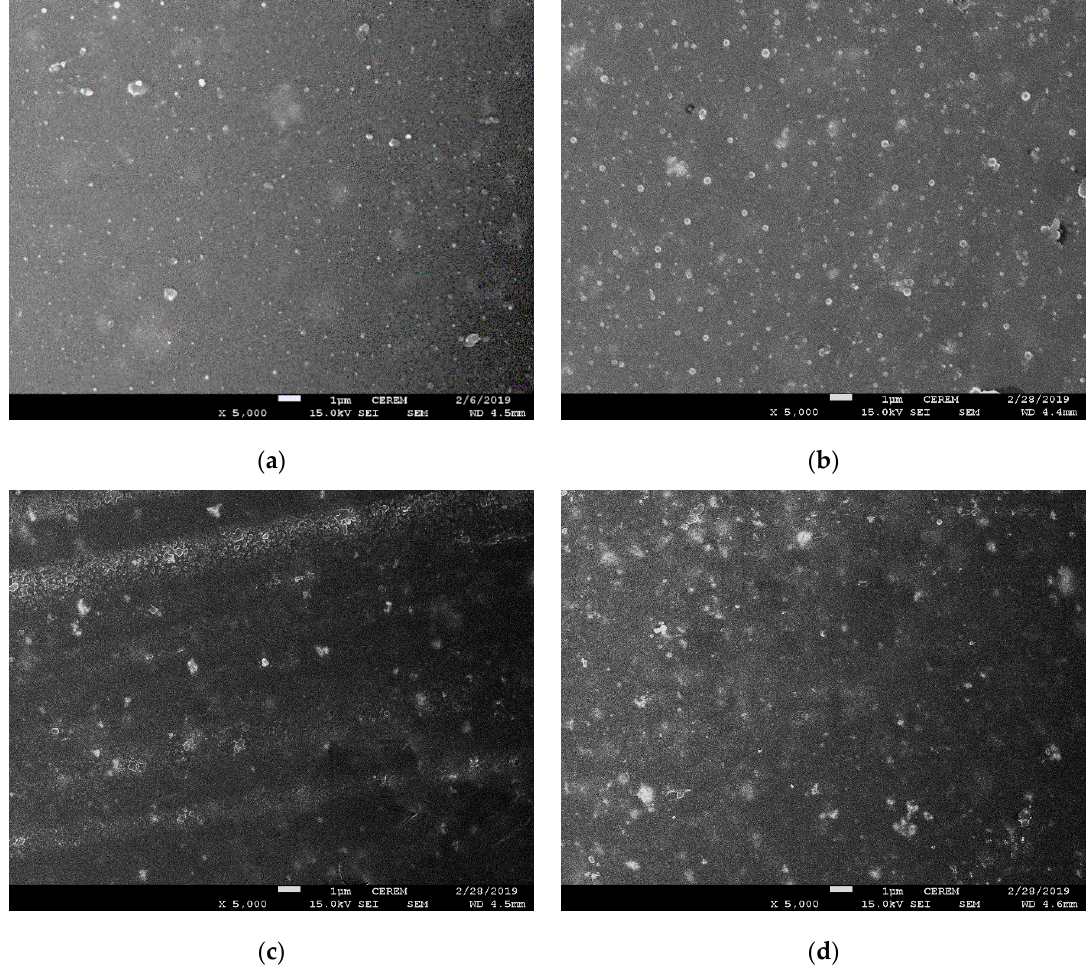
Figure 12. Scanning electron microscopy (SEM) images showing the representative surface morphology of the composite epoxy coatings ( a ) SNZ-0, ( b ) SNZ-1, ( c ) SNZ-2, and ( d ) SNZ-3.